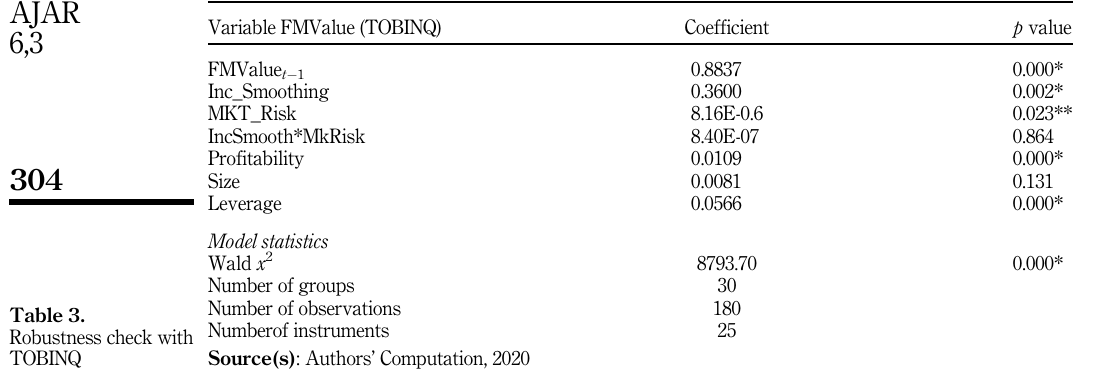
Table 3. Robustness check